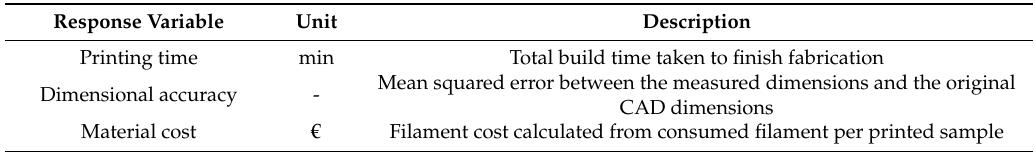
Table 5. Operational performance measurements for the